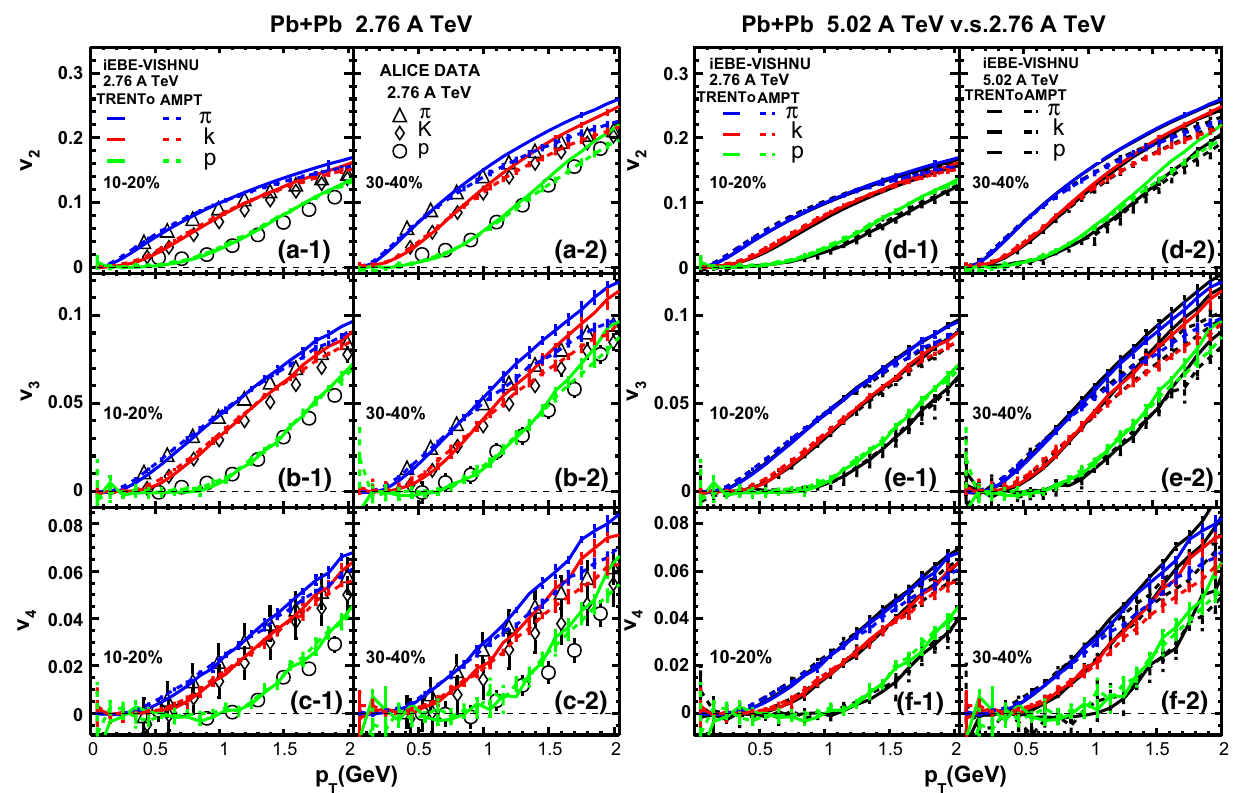
iEBE-VISHNU with TRENTo and AMPT initial conditions. The exper- imental data at 2.76 A TeV are taken from